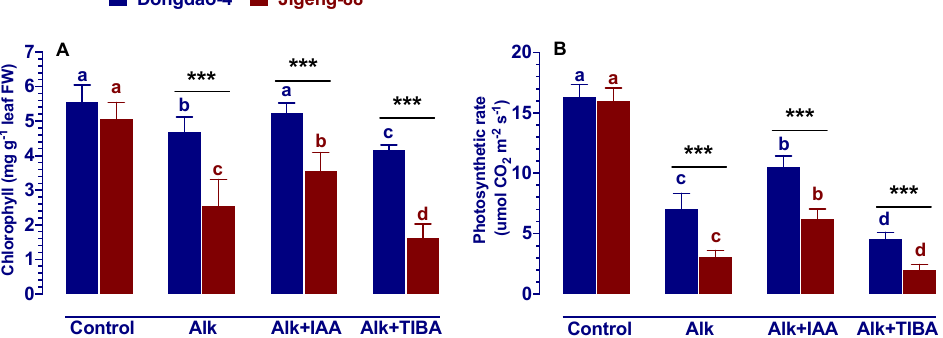
Figure 3. Effects of IAA and TIBA on ( A ) foliar chlorophyll concentration and ( B ) photosynthetic rates of Dongdao-4 and Jigeng-88 seedlings after treatment with alkaline stress. Treatments were as described in Figure 1. Means with different letters are significantly different ( p < 0.05) between control and “Alk” and “Alk + IAA” and “Alk + TIBA” of the same genotype. Asterisks indicate significant differences between different genotypes within the same treatment (*** p < 0.001).